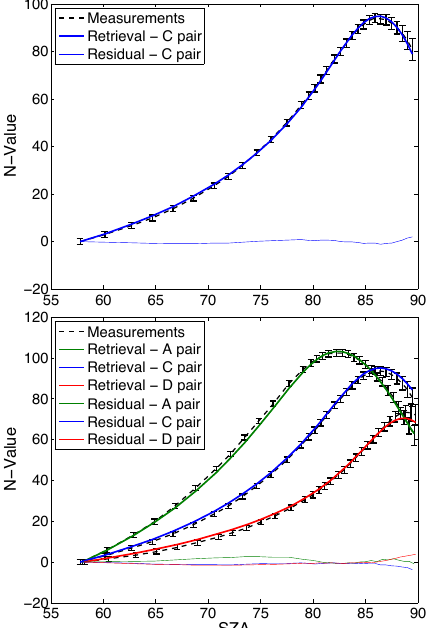
Figure 3. Simulated N values compared to the measurements after the iterative retrieval process when using only C-pair measurements (top panel) and using A + C + D-pair measurements (bottom panel) for 28 January 1994.